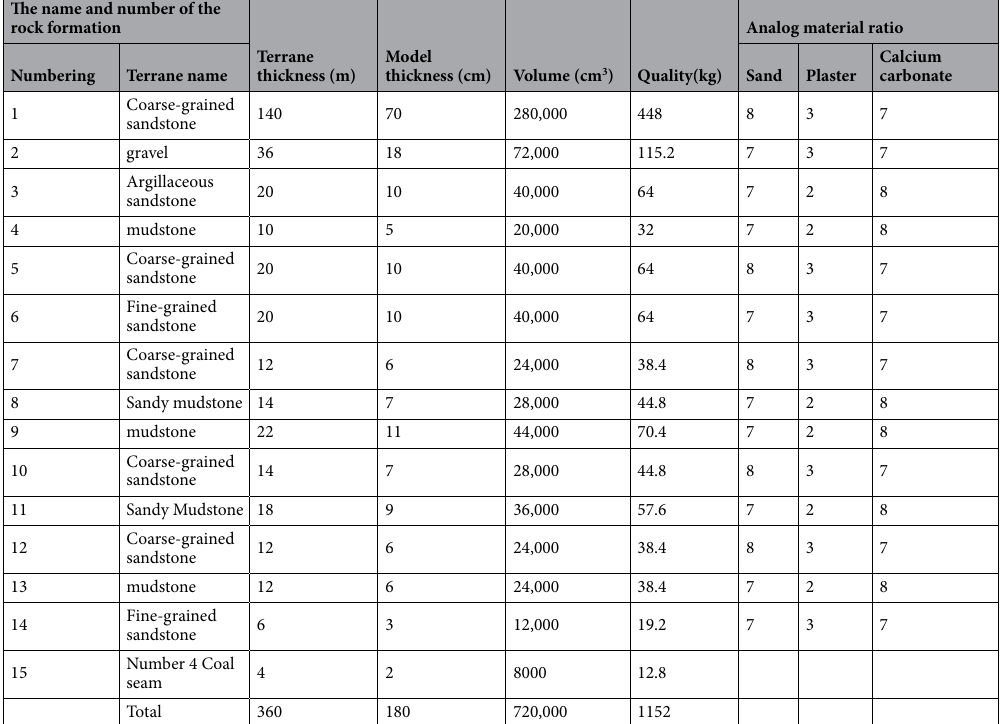
Table 2. Similar material simulation experiment stratigraphy statistics and material ratio table. Experimental equipment height is limited, and the coal seam is buried 600 m deep. According to the model scale, the